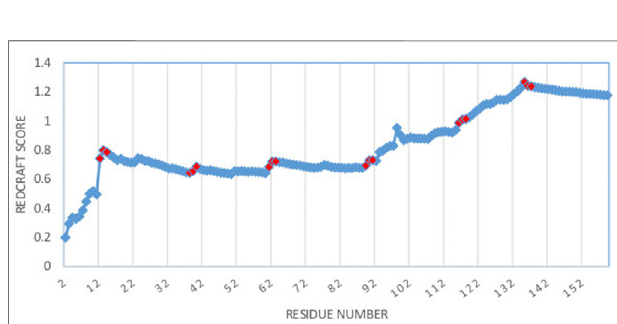
FIGURE 6 | Dynamic pro fi le of REDCRAFT for DHFR from residue 1 to 159. Hinge regionsfrom theimplemented MD simulation and markedinred to illustrate the correlation between the anomalous increases in DP and the transition between fragments with different internal